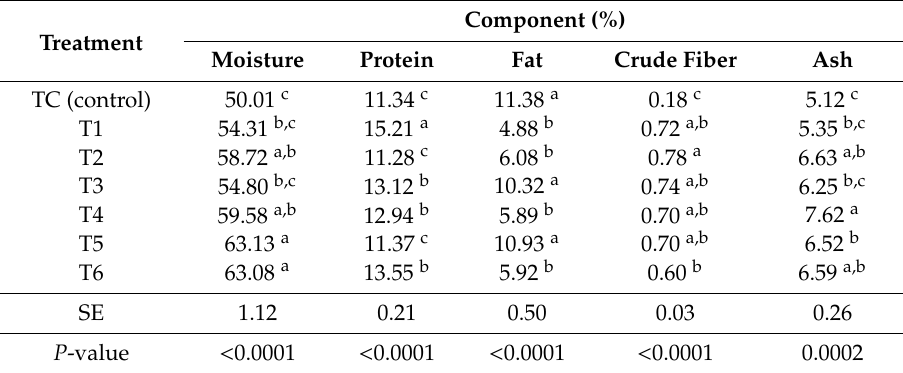
Table 3. Proximate composition of frankfurter sausages